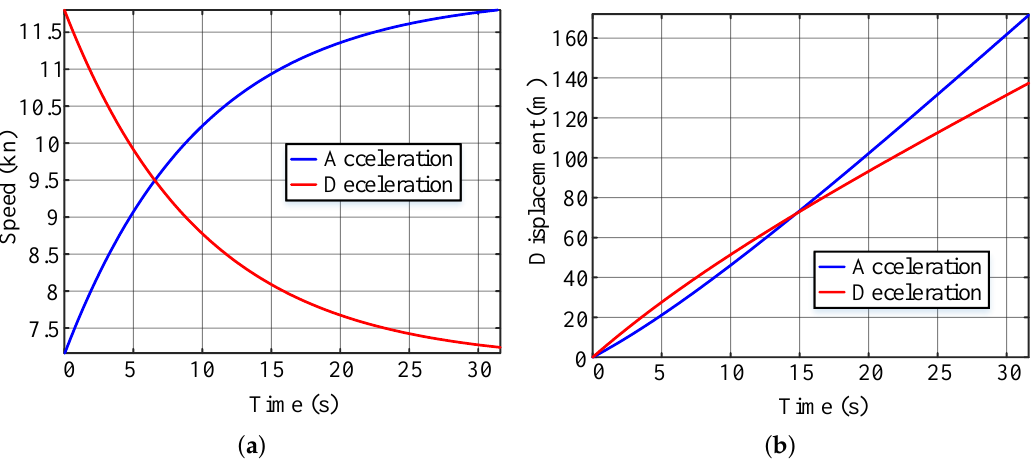
Figure 15. Acceleration and deceleration tests: ( a ) Speed test curves. ( b ) Displacement test curves.